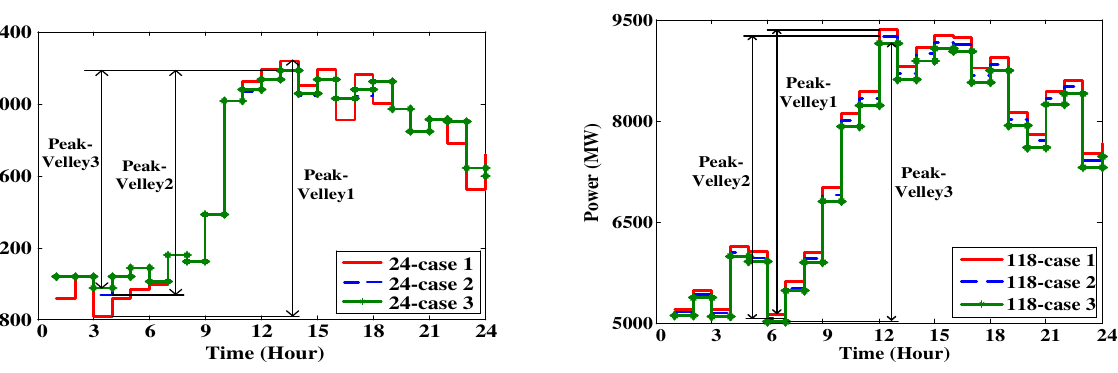
Fig. 10 Comparisons of difference of peak to valley of IEEE